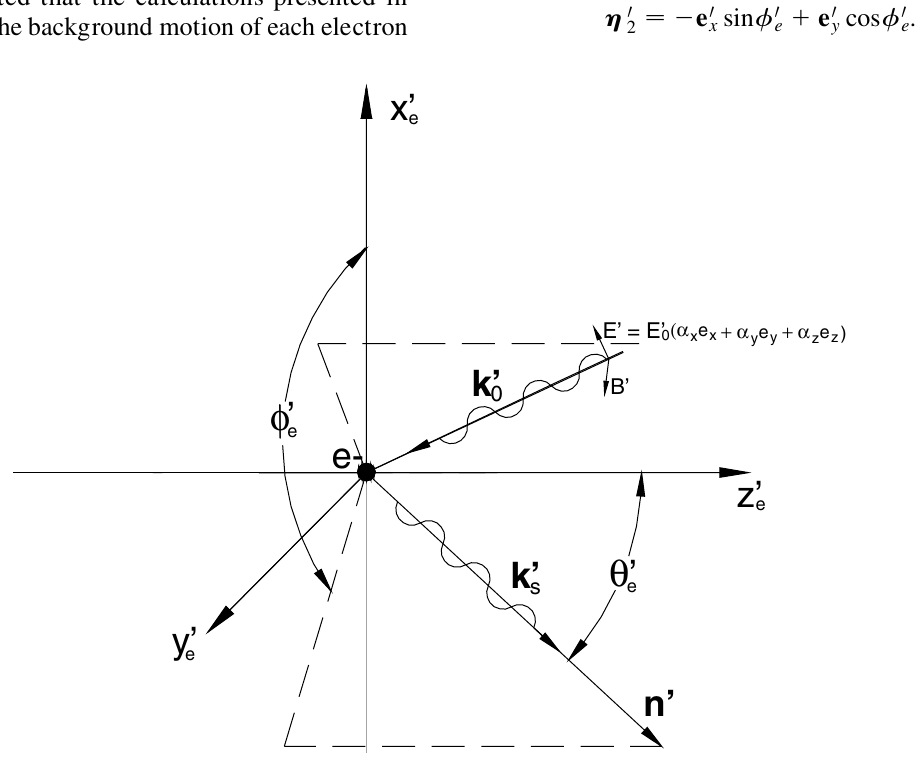
FIG. 1. Thomson interaction geometry in the electron rest